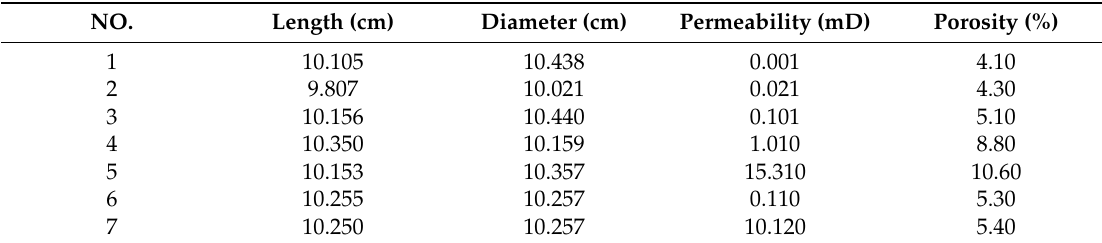
Table 2. Different experiments of water invasion conducted in this study.